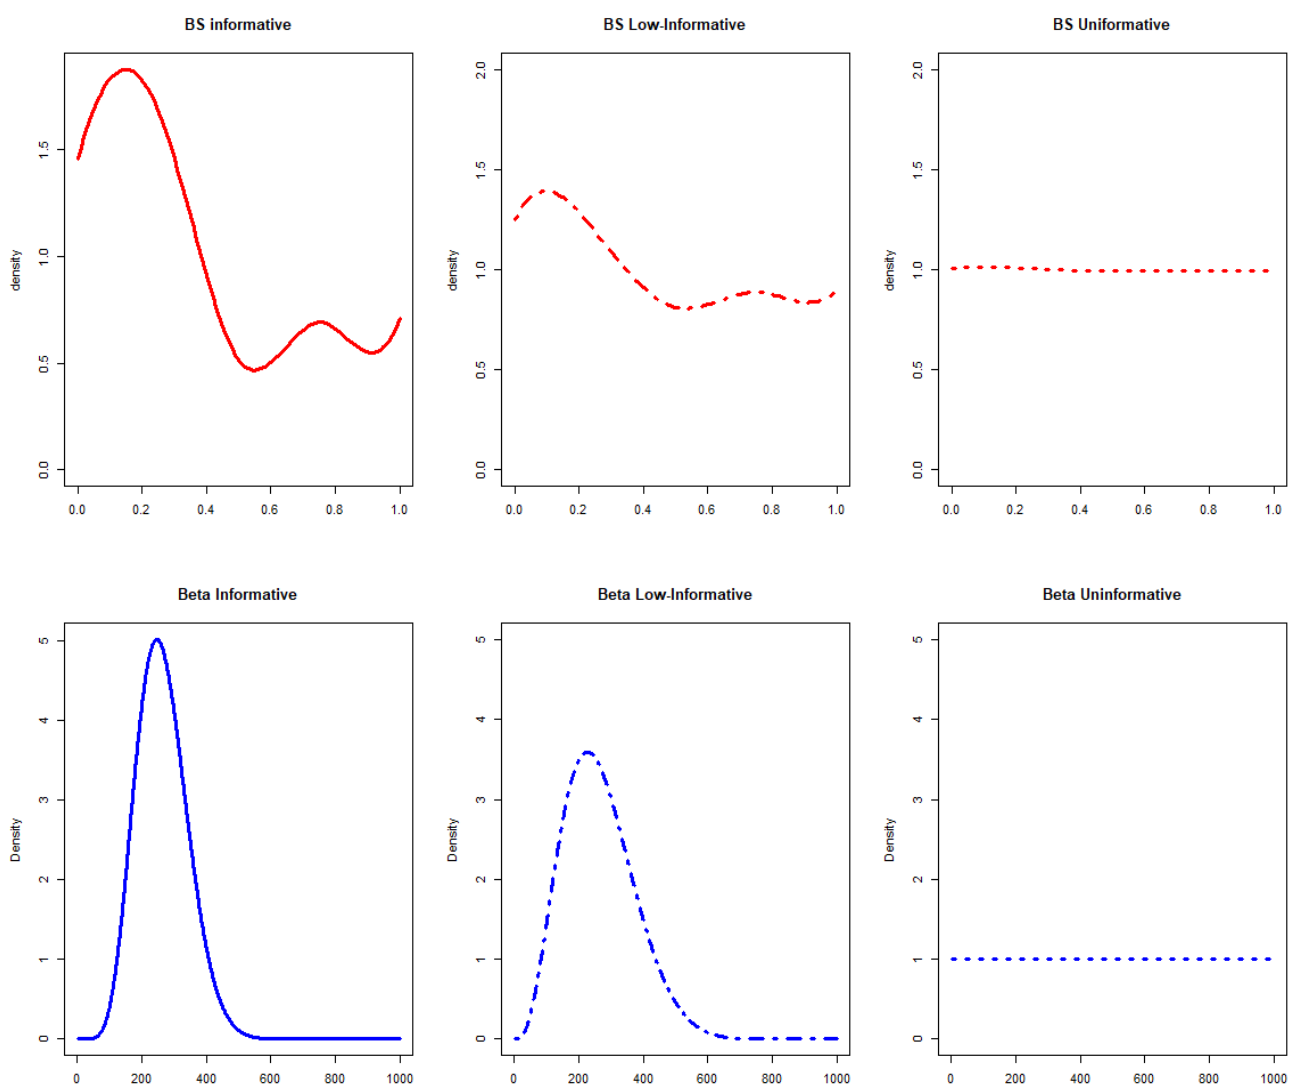
Figure 1. Prior distributions in a parametric (blue graphs) and semiparametric (red graphs) setting considering informative, low-informative, and uninformative scenarios. BS stands for B-splines. •